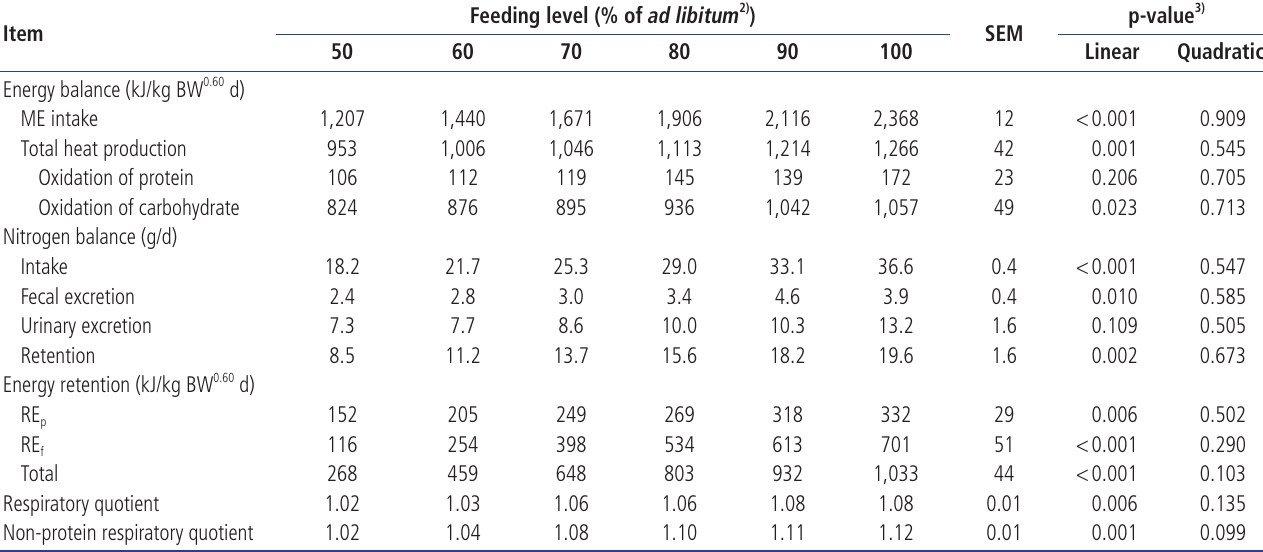
Table 3. Effects of feeding level on energy and nitrogen balance and energy retention in growing pigs 1)